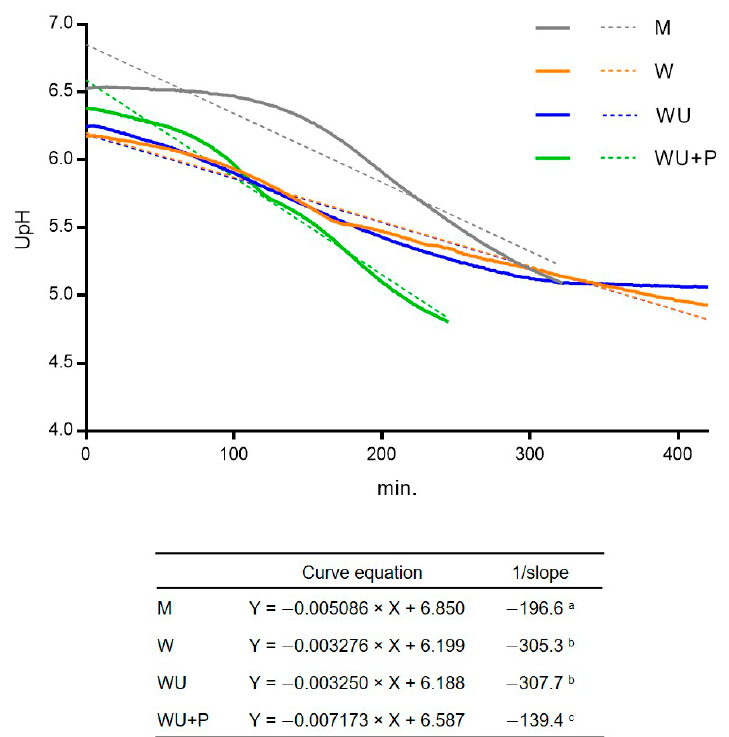
Figure 4. Acidification curves at 37 ◦ C of NSC inoculated in ovine milk, whey (W), whey ultrafiltered (WU), and WU supplemented with bacteriological peptone (WU + P). Continuous lines indicate the acidification activity during incubation. Dashed lines indicate linear regression of the acidification curves. Curve equations and 1/slopes are indicated in the table at the bottom of the figure. The 1/slopes not sharing the same apex letter differ significantly ( P < 0.0001), according to the Tukey- Kramer post hoc test.